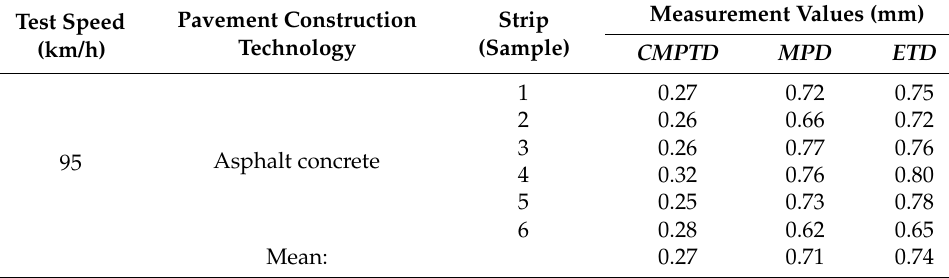
Table 13. Field tests results for asphalt concrete (95